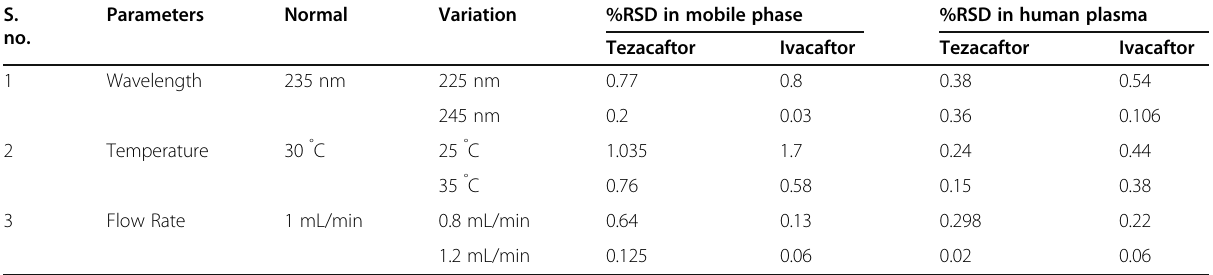
Table 10 Robustness study of Tezacaftor and Ivacaftor in Mobile phase and Human plasma S. no.